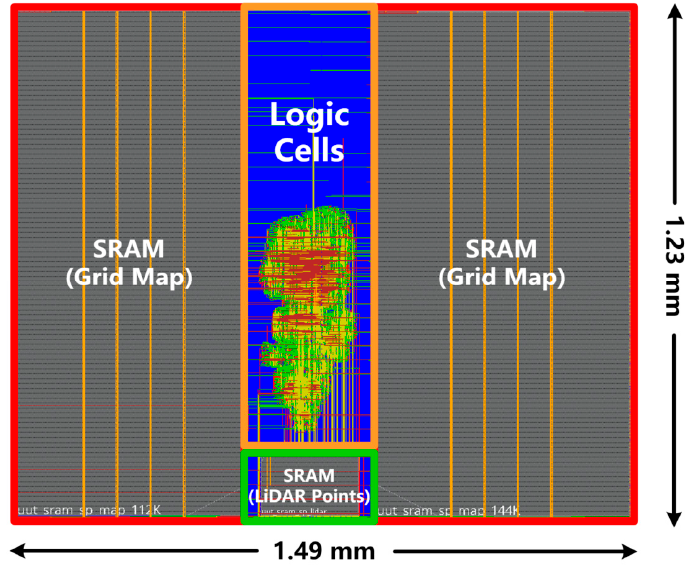
Figure 16. ASIC layout of the proposed NLO-CSM hardware accelerator core in 65 nm process.